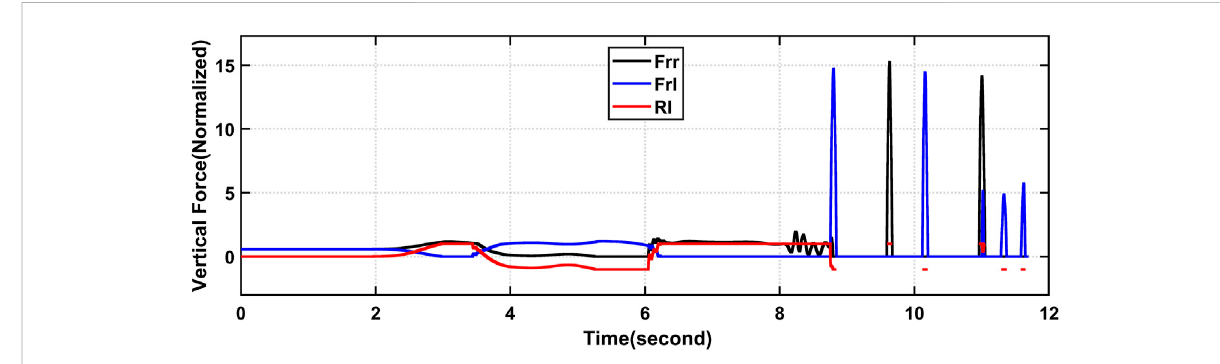
FIGURE 7 Comparison between the RI and the actual (normalized) vertical forces at the rear wheels at an increment of 170% of the maneuver.